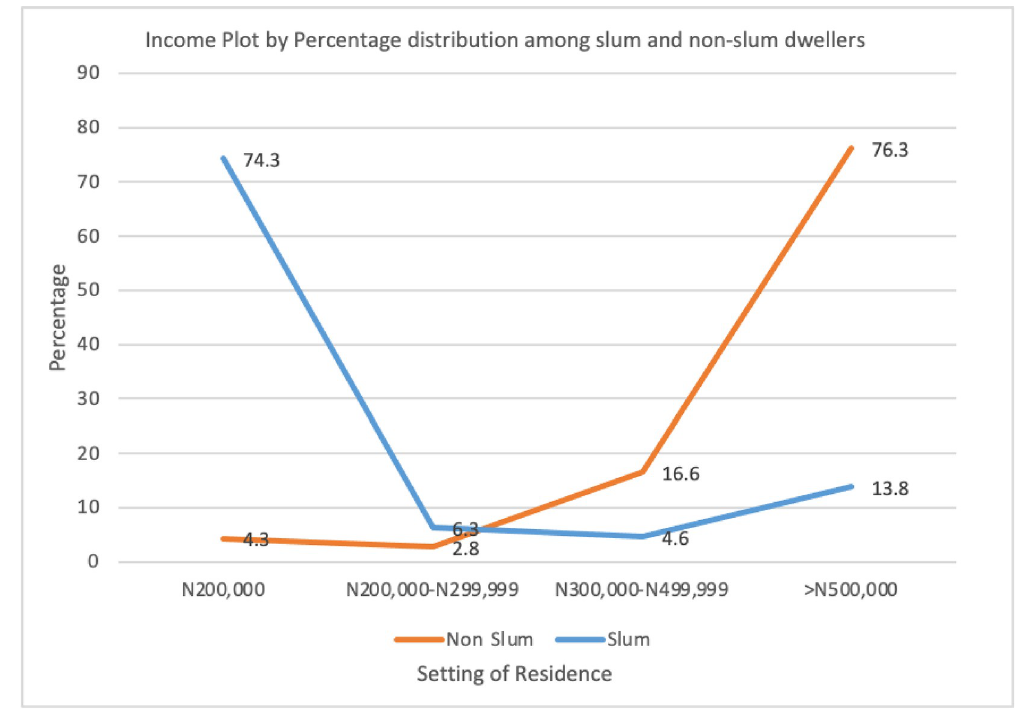
Fig 3. Income plot by percentage distribution among slum and non-slum